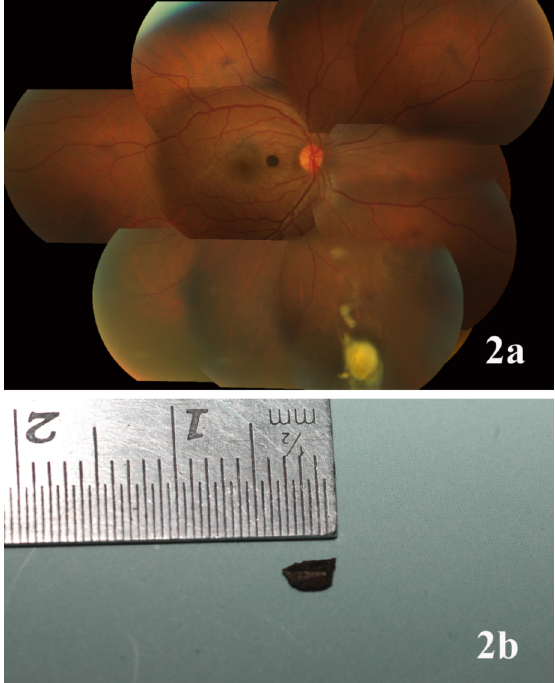
Figure 2: (a) Fundus montage of case 1 showing the IOFB obscured by surrounding exudates in the inferior